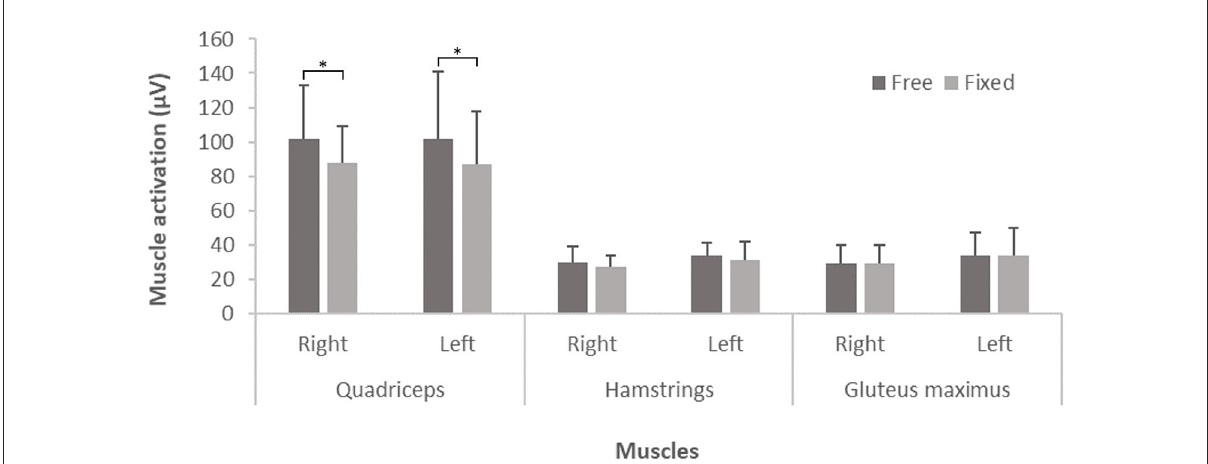
FIGURE2 Mean ± standard deviation of muscle activation (min µ V) of the entire squat of the mid three repetitions of the loaded barbell squat in quadriceps, hamstrings and gluteus maximus when performed in a free movement path and in a fixed vertical movement path, respectively ( n = 16). An asterisk indicates a statistically significant difference in muscle activation between conditions. A two-way repeated measures ANOVA was used to compare muscle activation between conditions, i.e., free vs. fixed movement path. The order of the two conditions did not interact with the main